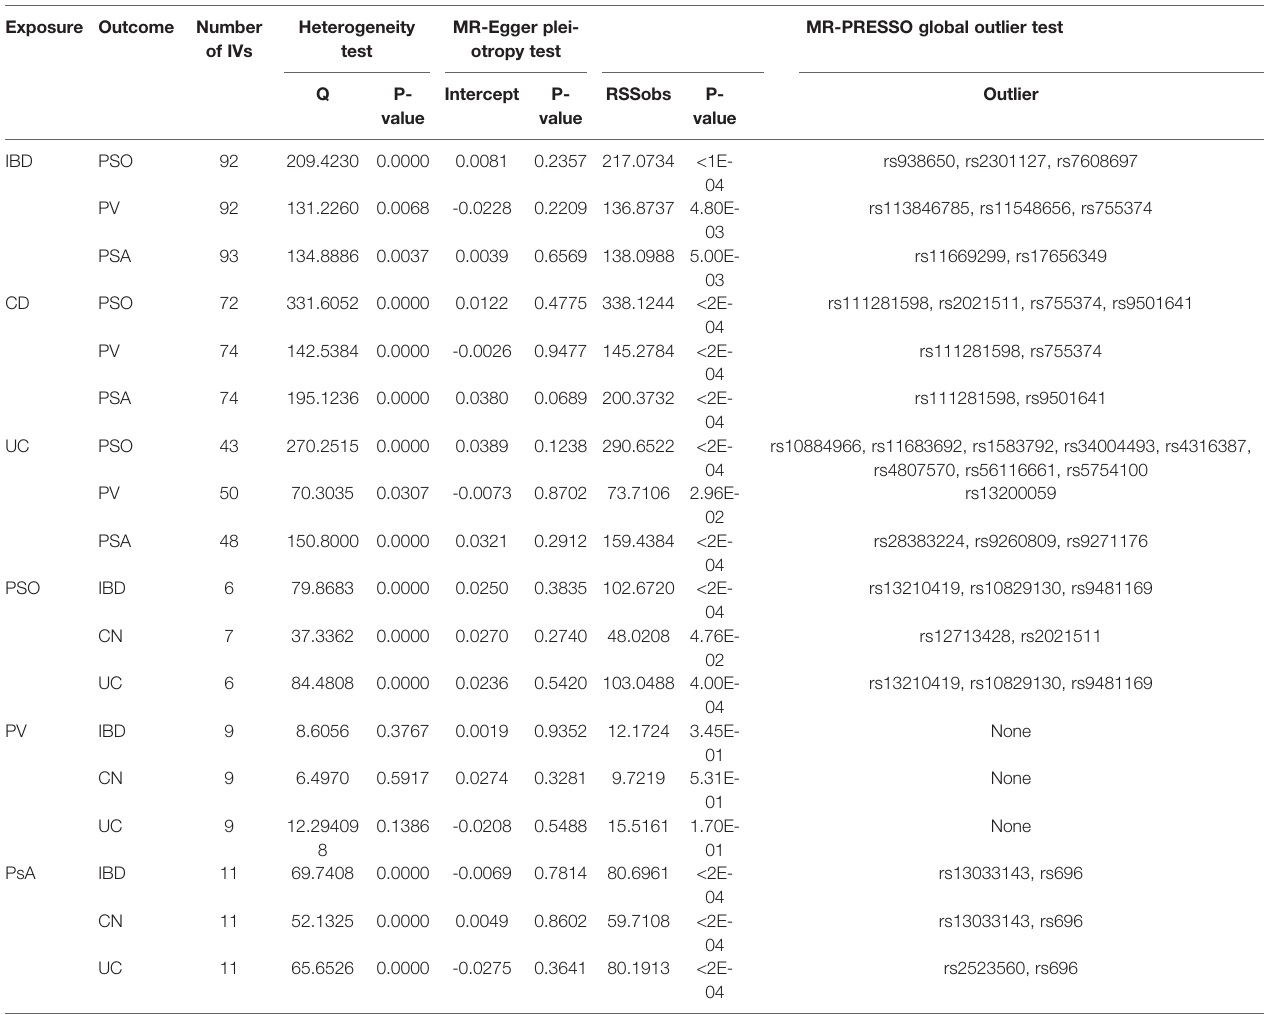
TABLE 1 | Sensitivity analyses of